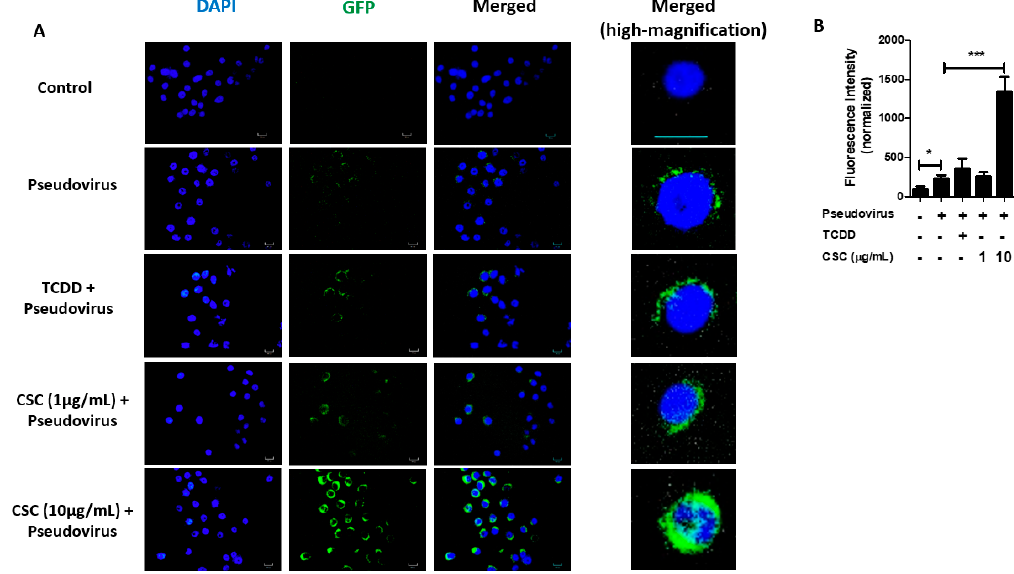
Figure 4. Pretreatment with cigarette smoke condensates increases severe acute respiratory syndrome coronavirus 2 (SARS-CoV-2) pseudovirus infection in gingival epithelial cells. Human gingival epithelial cells (GECs) were treated with or without cigarette smoke condensates at different concentrations as indicated, or with 2,3,7,8-tetrachlorodibenzo-p-dioxin (TCDD, 10 nM), for 24 h, prior to infection with SARS-CoV-2 pseudotyped GFP-tagged lentivirus for an additional 24 h. SARS-CoV-2 pseudovirus infection was visualized by immunofluorescence microscopy. ( A ) shows representative images of immunofluorescence for GFP-tagged SARS-CoV-2 pseudovirus. ( B ) Graph shows average percentage ± SEM of GFP fluorescence intensity, measured using Image J. ( A , B ) n = 3. * p ≤ 0.05; *** p ≤ 0.001. Diameter bar = 100 µ